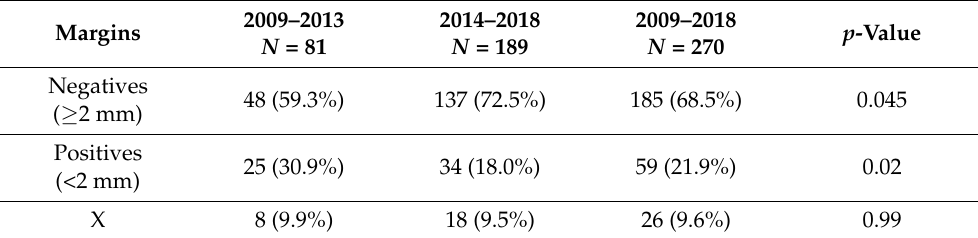
Table 4. Division of patients based on resection